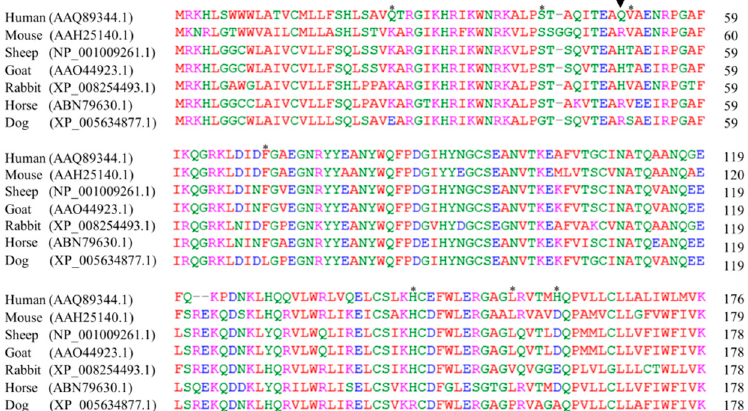
Figure 4. Comparisons of amino acid sequences of prion-like protein (Doppel) in human, mouse, sheep, goat, rabbit, horse, and dog. Prion-like protein sequences were obtained from GenBank at the National Center for Biotechnology Information (NCBI), including those of human ( Homo sapiens , AAQ89344.1), mouse ( Mus musculus , AAH25140.1), sheep ( Ovis aries , NP_001009261.1), goat ( Capra hircus , AAO44923.1), rabbit ( Oryctolagus cuniculus , XP_008254493.1), horse ( Equus caballus , ABN79630.1), and dog ( Canis lupus familiaris , XP_005634877.1). Doppel protein sequences were aligned among various species using ClustalW2. Colors symbolize the chemical properties of amino acids (blue: acidic; red: small and hydrophobic; magenta: basic; green: hydroxyl, sulfhydryl, amine and glycine). The arrow denotes the nonsynonymous single nucleotide polymorphism (SNP) (c.149G>A, R50H) found in this study. Asterisks indicate dog-specific residues.